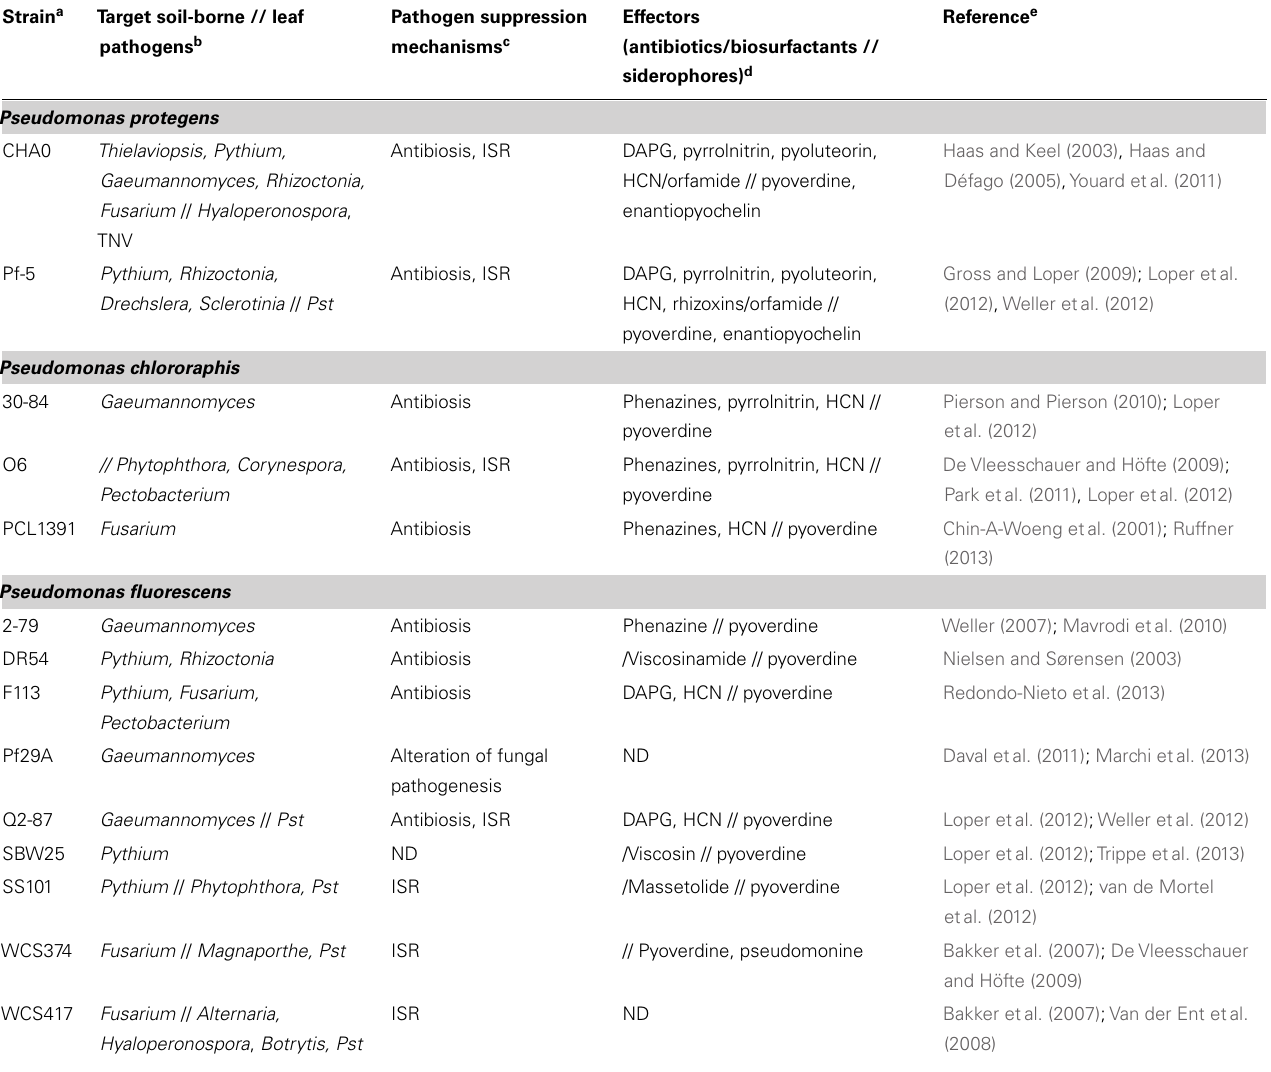
Table 1 | Prominent root-associated Pseudomonas fluorescens group strains with biocontrol activity against plant diseases and effectors contributing to pathogen